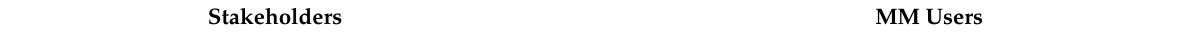
Table 1. Inclusion criteria for each